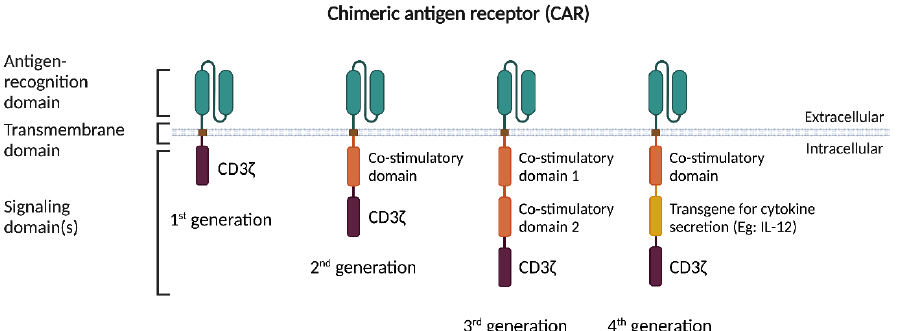
Figure 1. Evolution of CAR constructs. The molecular design of CARs is comprised of three regions: (i) an ectodomain comprising an antigen-binding module; (ii) a transmembrane domain as an anchor; and (iii) a signaling domain for T cell activation. First-generation CARs contain only a single signaling domain (CD3 ζ ). Second-generation CAR constructs include a co-stimulatory domain along with the signaling domain. Third-generation CARs are comprised of two co-stimulatory domains connected to the intracellular signaling domain. Fourth-generation CARs, also referred to as TRUCKs, have an inducible transgene construct that expresses cytokines, for instance IL-12. CAR-T, chimeric antigen receptor T; CD3ζ, cluster of differentiation 3 zeta -chain); IL-12, interleukin 12. Figure created with BioRender (biorender.com).